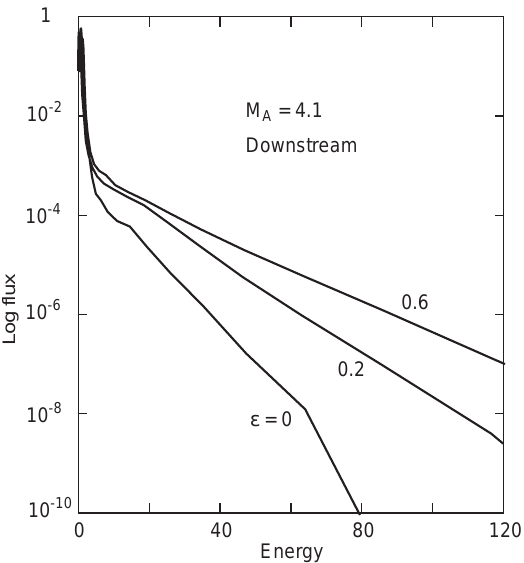
Fig. 1. Flux distributions for protons downstream of a M A (cid:136) 4 : 1 shock at X cp t (cid:136) 600 in a log versus linear representation. Energy is measured relative to the shock frame of reference in units of the plasma ramming energy E p . Di(cid:128)erent levels of initially superimposed fluctuations have been used ( (cid:15) (cid:136) 0 ; 0 : 2 and 0.6) Fig. 2. Same as Fig. 1 in a